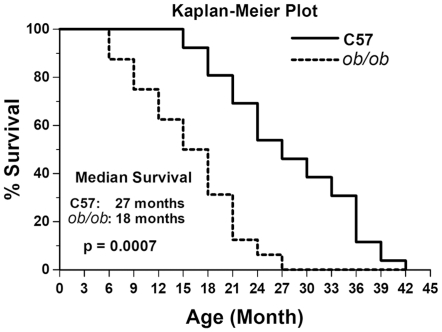
Cumulative survival curve (Kaplan-Meier survival plot) of male C57
lean and ob/ob obese mice.The cumulative survival rate was plotted against age in months. The Log
rank test was performed to compare the two mouse groups
(p = 0.0007).
n = 26 and 16 mice for C57 and
ob/ob mice, respectively.